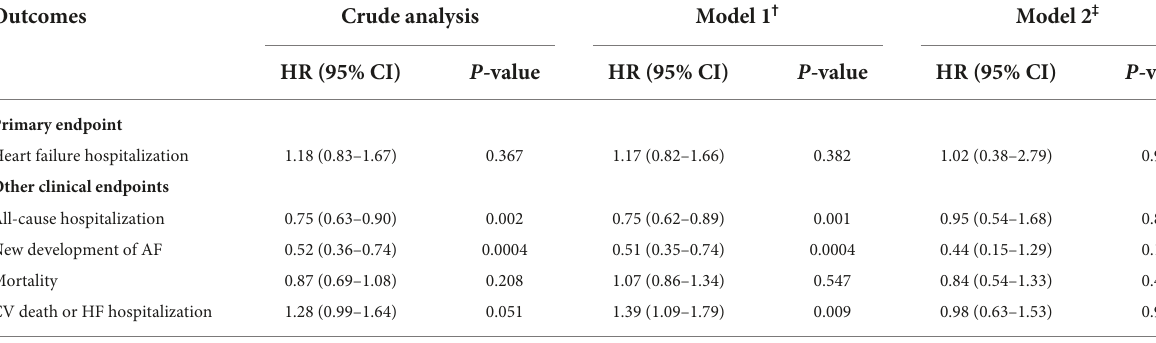
TABLE 3 Clinical outcomes between ivabradine and non-ivabradine groups by different adjusted analysis after IPTW. Outcomes